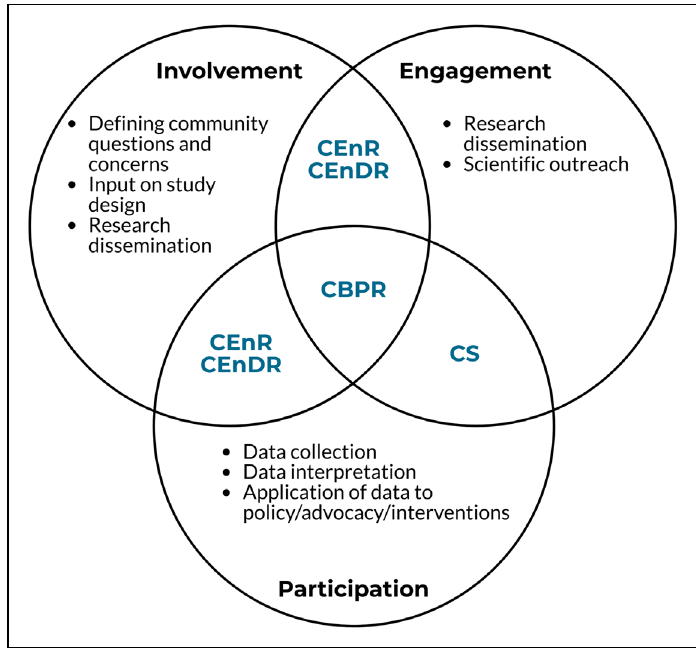
Figure 1 Venn diagram of intersections between citizen science (CS), community-engaged research (CEnR), community-engaged disaster research (CEnDR), and community-based participatory research (CBPR) aligned with elements of engagement, involvement, and participation, as described by Wooley et al